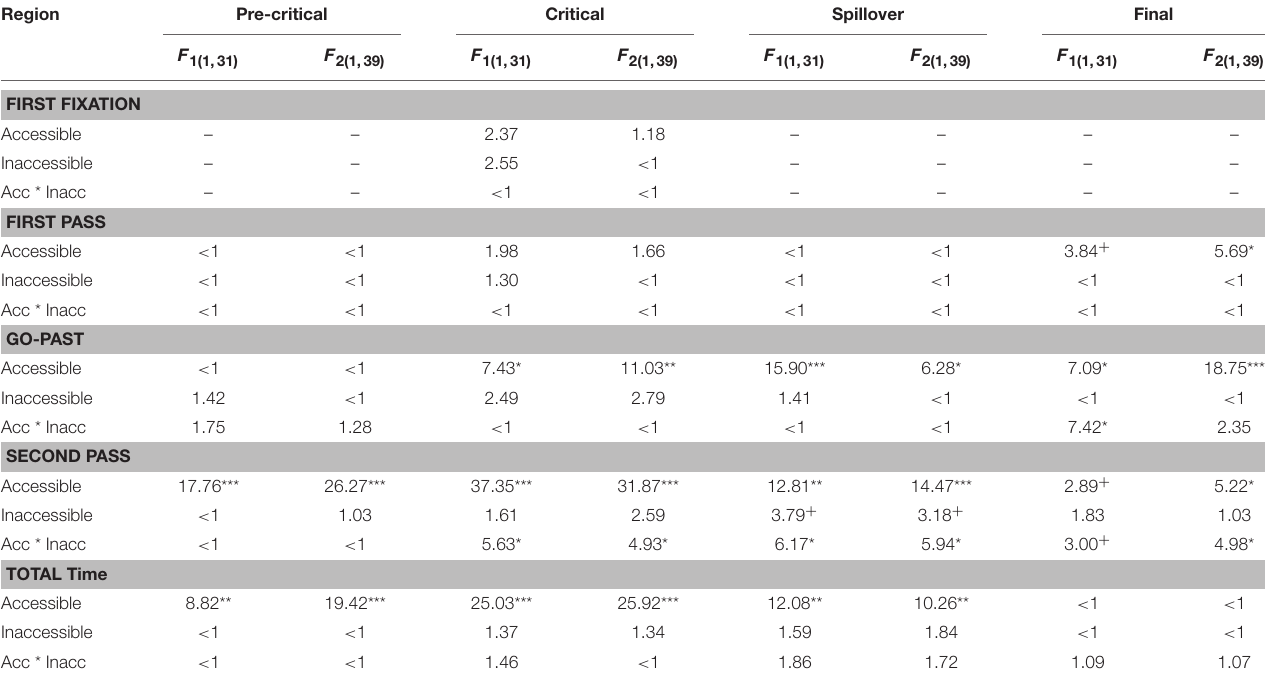
TABLE 8 | Anova results for Experiment 4 ( + p < 0 . 1 ; * p < 0 . 05 ; ** p < 0 . 01 ; *** p < 0 . 001 ).